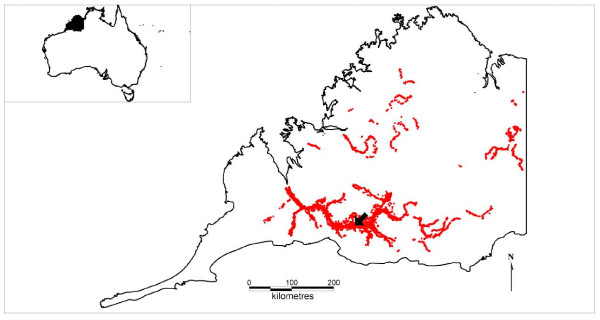
Feral pig distribution in the Kimberley. The red dots represent simulated pig herds within known wild pig distributions. The black arrow indicates the introduction site for all simulations. The inset displays the location of the Kimberley region in North West Australia.